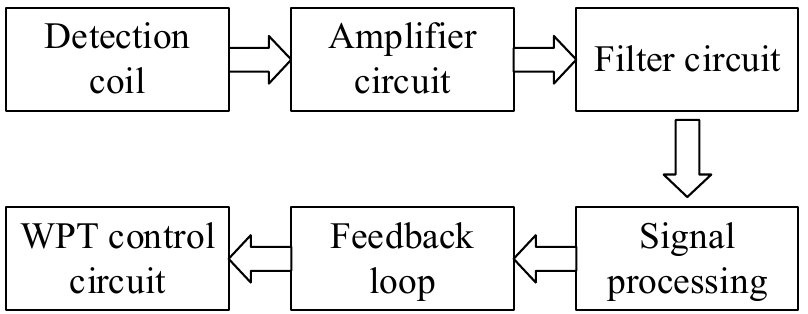
Figure 11. Block diagram of the detection system with an additional circuit.